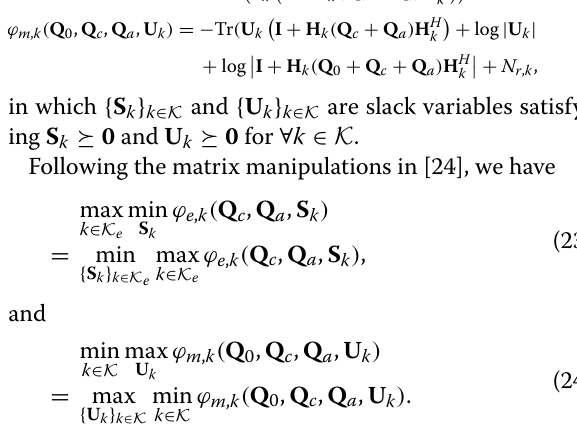
Algorithm 2. In line 6 of Algorithm 2, the convex sub-